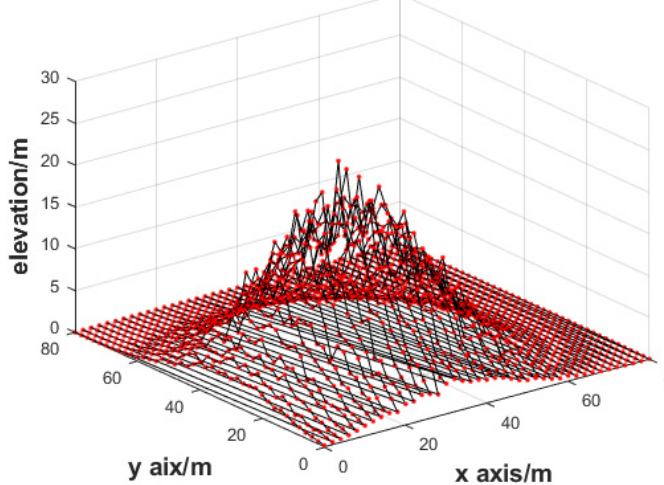
Figure 5. DTM with multiplicative error.